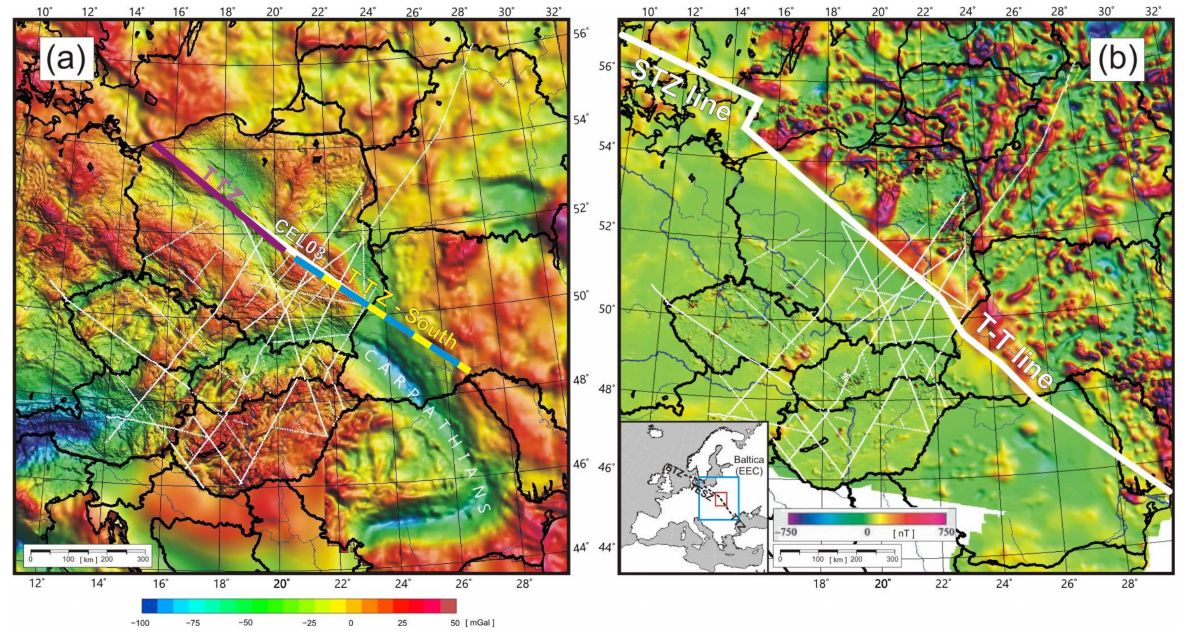
Figure 4. Location of the TTZ-CEL03-TTZ-South transect and the Teisseyre–Tornquist line on potential field maps of Central Europe (modified after Wybraniec & Majorowicz [80]). ( a ) The TTZ-CEL03-TTZ-South transect is shown on a Bouguer gravity anomaly map. ( b ) The T-T line is shown on a map of magnetic anomalies illuminated from the SE. T-T line—Teisseyre–Tornquist line; STZ—Sorgenfrei–Tornquist zone; thin white lines represent the net of CELEBRATION 2000 profiles. The bottom left inset in ( b ) shows the location of the study area (red rectangle) and the location of the maps ( a , b ) in Europe (blue box). EEC—East European craton; TESZ—Trans-European Suture zone; TTZ—Teisseyre-Tornquist